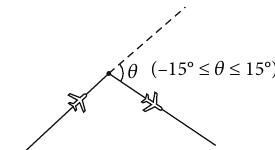
Figure 2: Turning angle of the